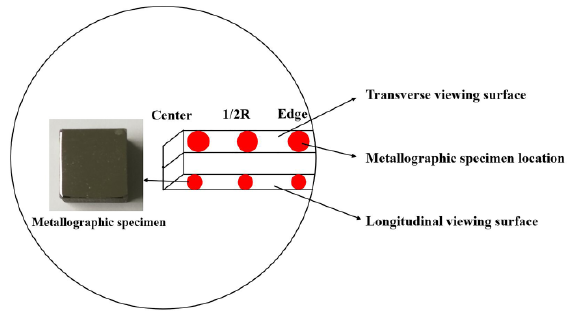
Figure 2. Schematic diagram of the metallographic specimen obtained.